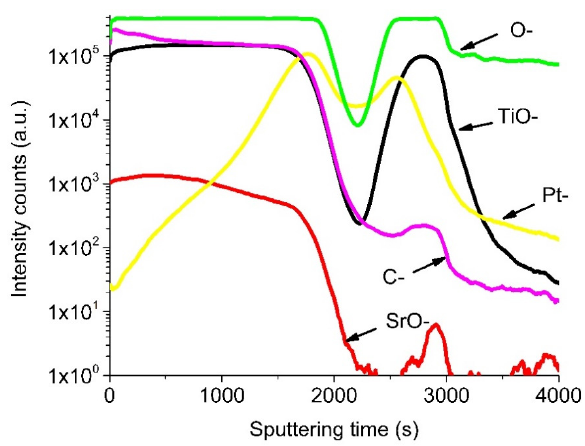
Figure 6. SIMS depth distribution of the precursor components in the Si/TiO x /Pt/SrTiO 3 heterostructure.